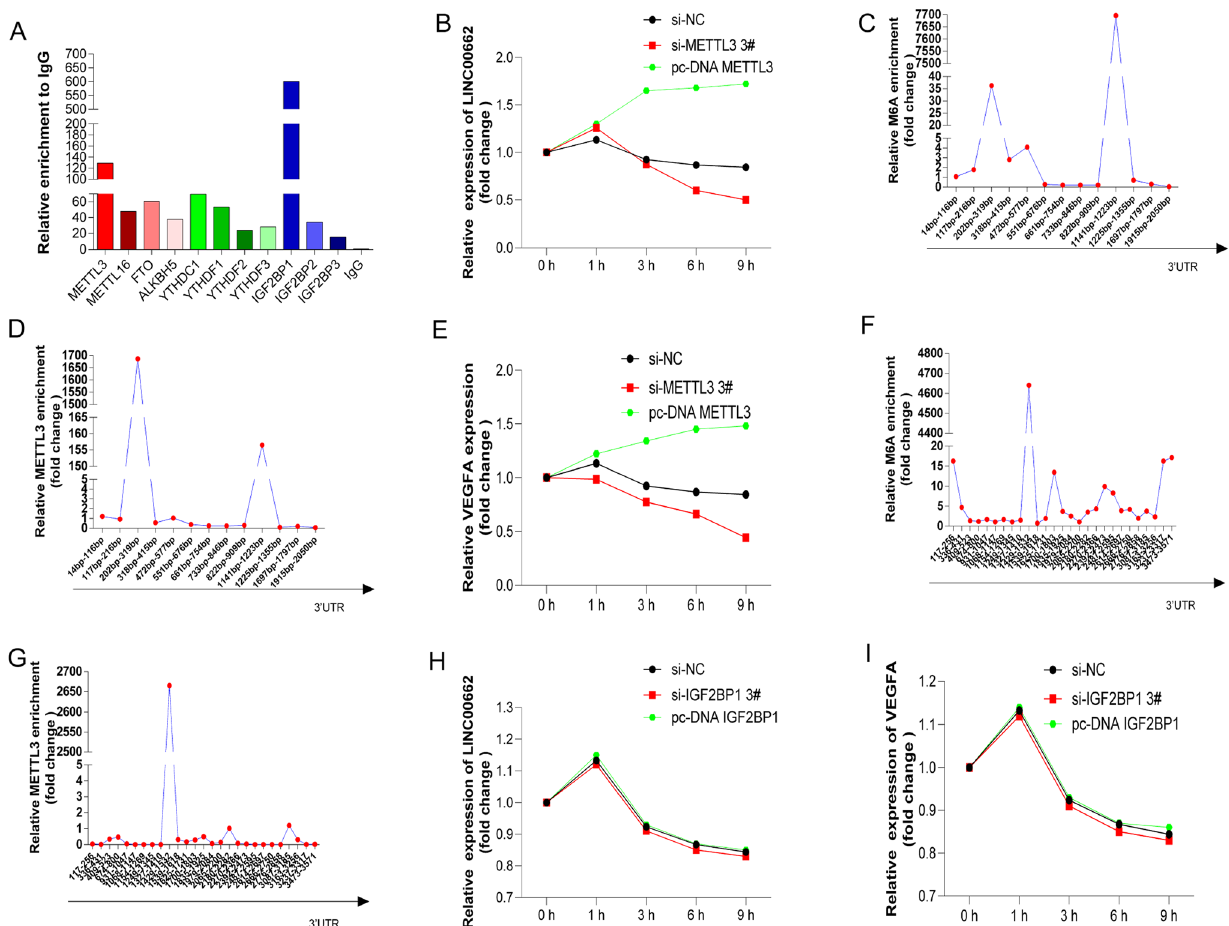
Fig. 5 METTL3 dual regulation of LINC00662 and VEGFA RNAs stability. A RIP experiments verified the enrichment levels of LINC00662 and m6A enzymes. B Expression of LINC00662 RNA at 0 h, 1 h, 3 h, 6 h and 9 h after interference and overexpression of METTL3. C Validation of m6A enrichment level of LINC00662 RNA by MeRIP assay. D Validation of Mettl3 enrichment level of LINC00662 RNA by MeRIP assay. E Expression of VEGFA mRNA at 0 h, 1 h, 3 h, 6 h and 9 h after interference and overexpression of METTL3. F Validation of m6A enrichment level of VEGFA mRNA by MeRIP assay. G Validation of METTL3 enrichment level of VEGFA mRNA by MeRIP assay. H Expression of LINC00662 RNA at 0 h, 1 h, 3 h, 6 h and 9 h after interference and overexpression of IGF2BP1. I Expression of VEGFA mRNA at 0 h, 1 h, 3 h, 6 h and 9 h after interference and overexpression of